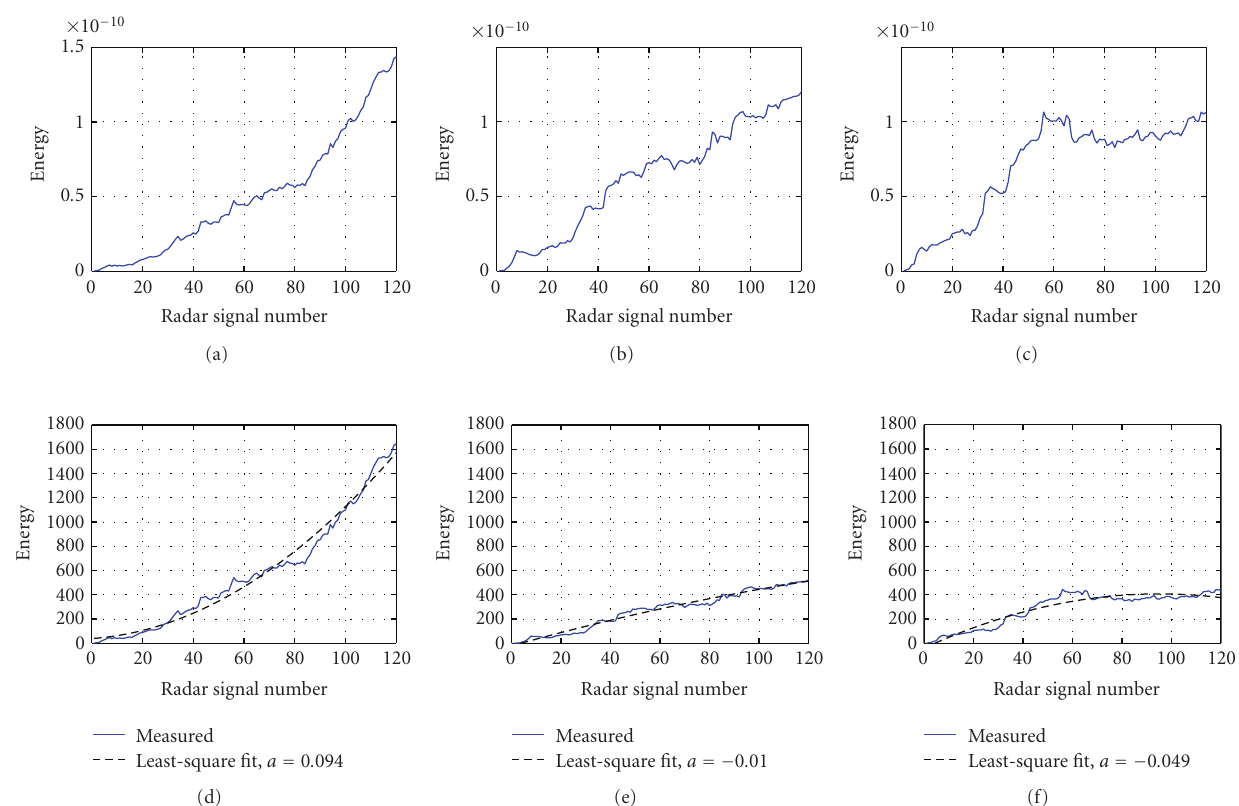
Figure 8: Curves of energy collection at focal points P T , P 1 , and P 2 (see Figure 6(a)): (a) curve for P T as in standard DAS, (a) curve for P 1 as in standard DAS, (c) curve for P 2 as in standard DAS, (d) curve for P T as in improved DAS together with the fitted polynomial, (e) curve for P 1 in the improved DAS together with the fitted polynomial, (f) curve for P 2 in the improved DAS together with thefitted